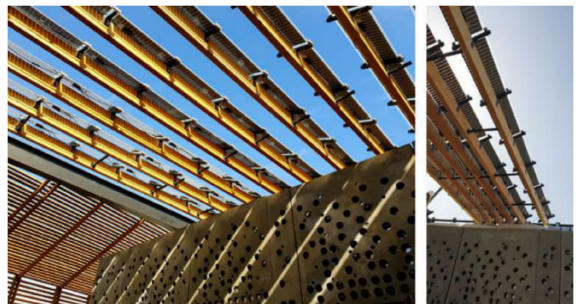
Figure 12. Movable PV integrated roof over BAITYKOOL house. Adapted from ref.